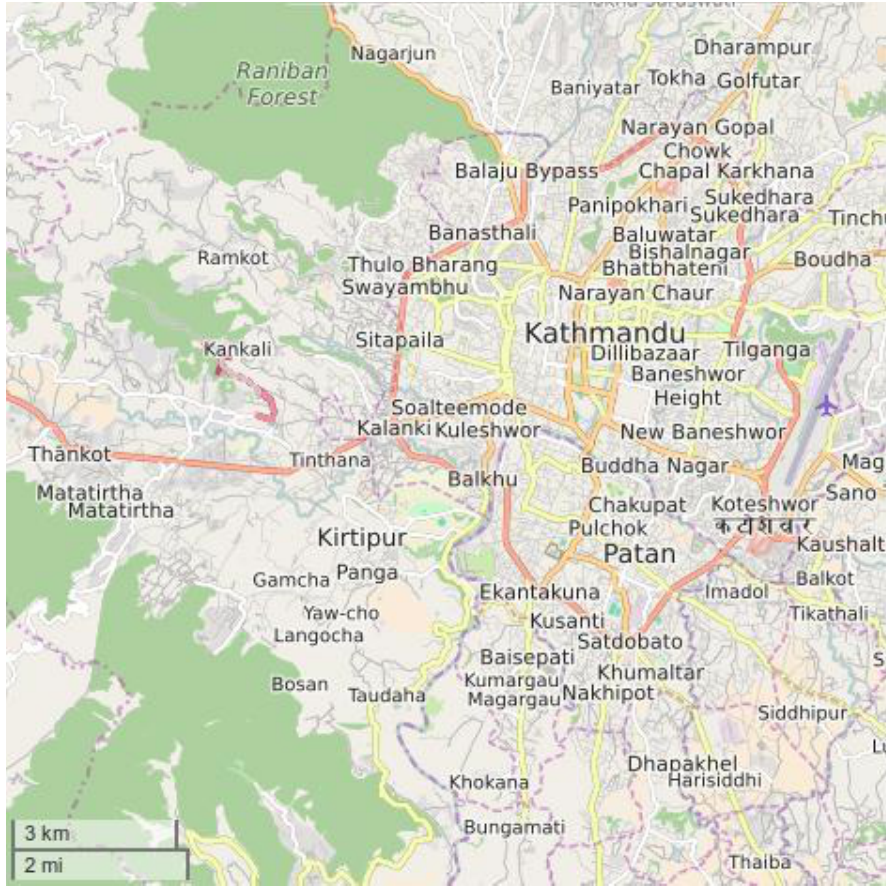
Figure 2. Location of the study area in Kathmandu, Nepal. Copyright: © OpenStreetMap contributors.